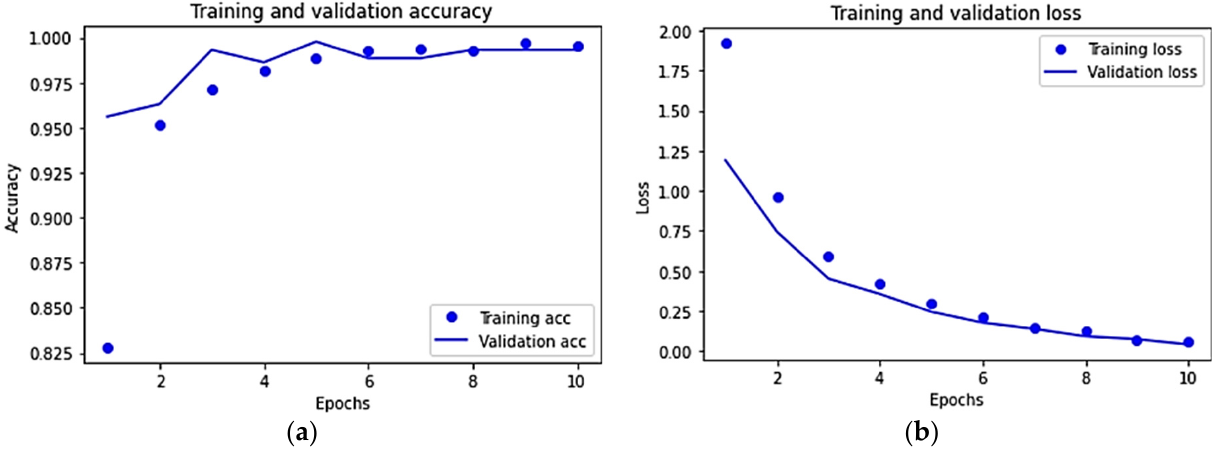
Figure 8. For the VGG16 fine-tuning pre-trained model: ( a ) training and validation accuracy, and ( b ) Training and validation loss. Table 2. Comparison of the test accuracy and loss for the CNN-based models.